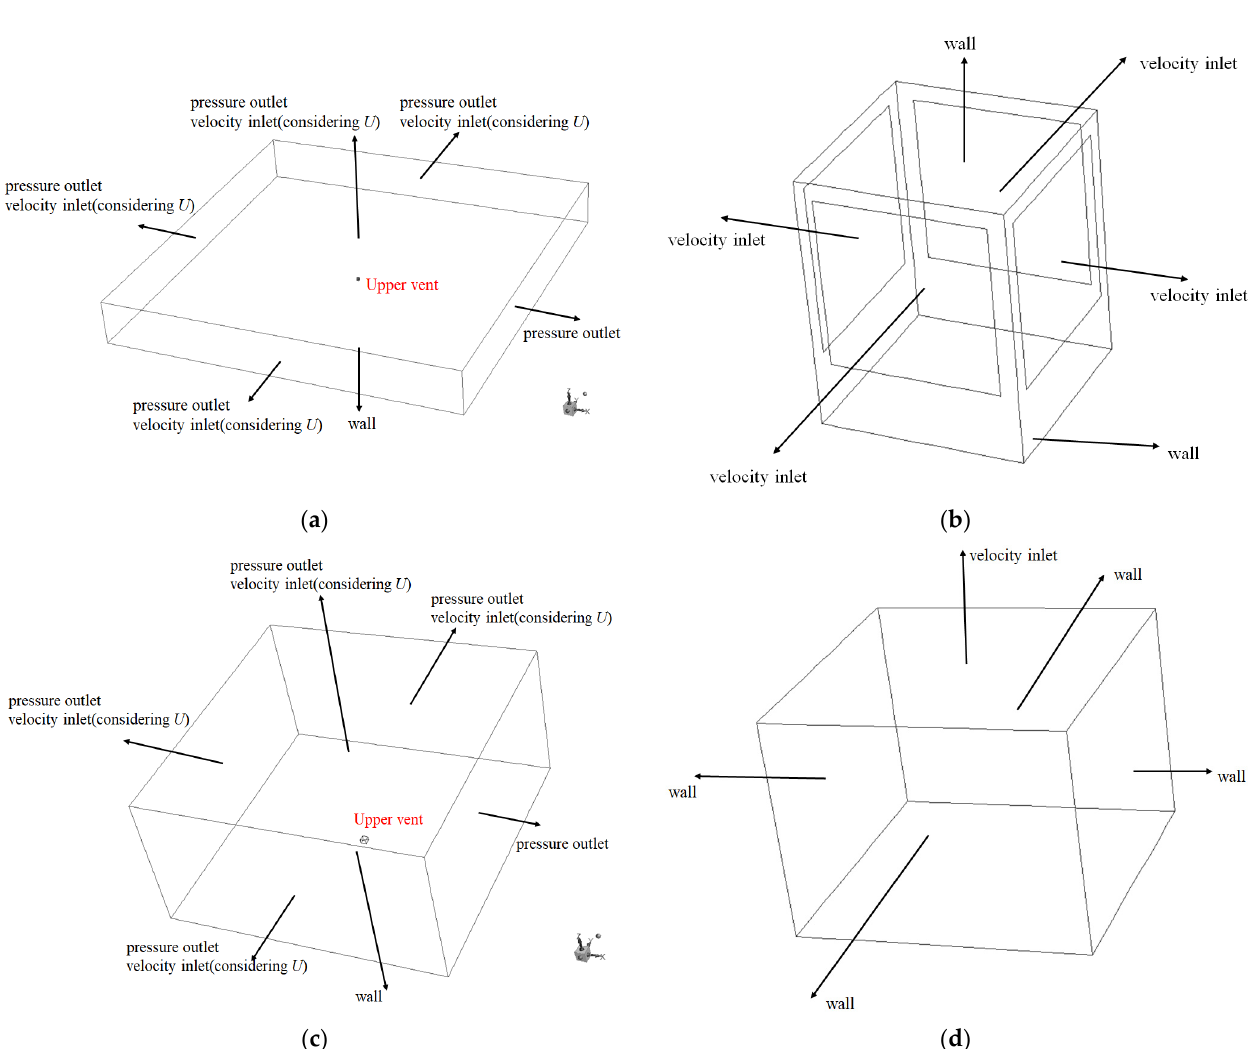
Figure 4. Schematic diagram of the boundary conditions: ( a ) external air area for the horizontal upper vent; ( b ) upper vent in the horizontal discharge pattern; ( c ) external air area for the vertical upper vent; ( d ) upper vent in the vertical discharge pattern.